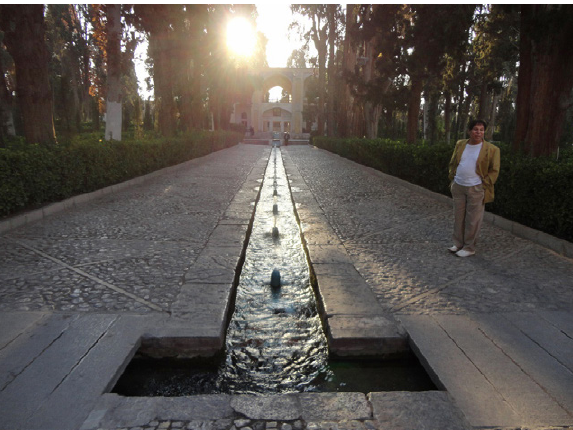
Figure 2. Geoometry of water in Fin-Garden,